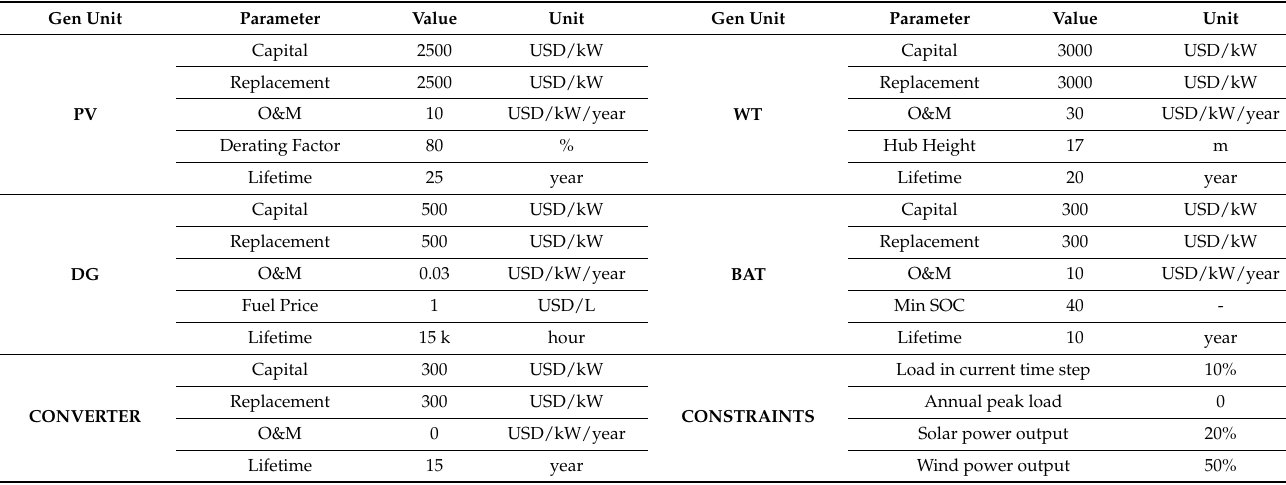
Table 4. Economical and constraints